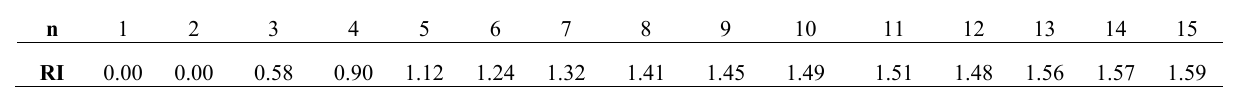
Figure 1. Hierarchy model showing the criteria and options. Table 1. Random Consistency Index